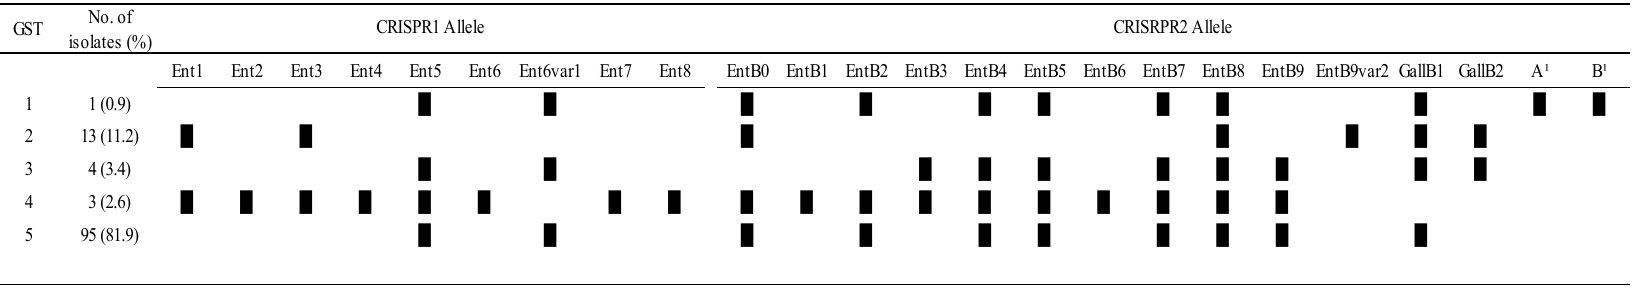
Figure 1. Spacer content of CRISPR alleles and grouping of 116 Salmonella Gallinarum isolates into Gallinarum Sequence Types (GSTs). Repeats are not included and only spacers are represented. ¹ Spacers newly discovered in this study.